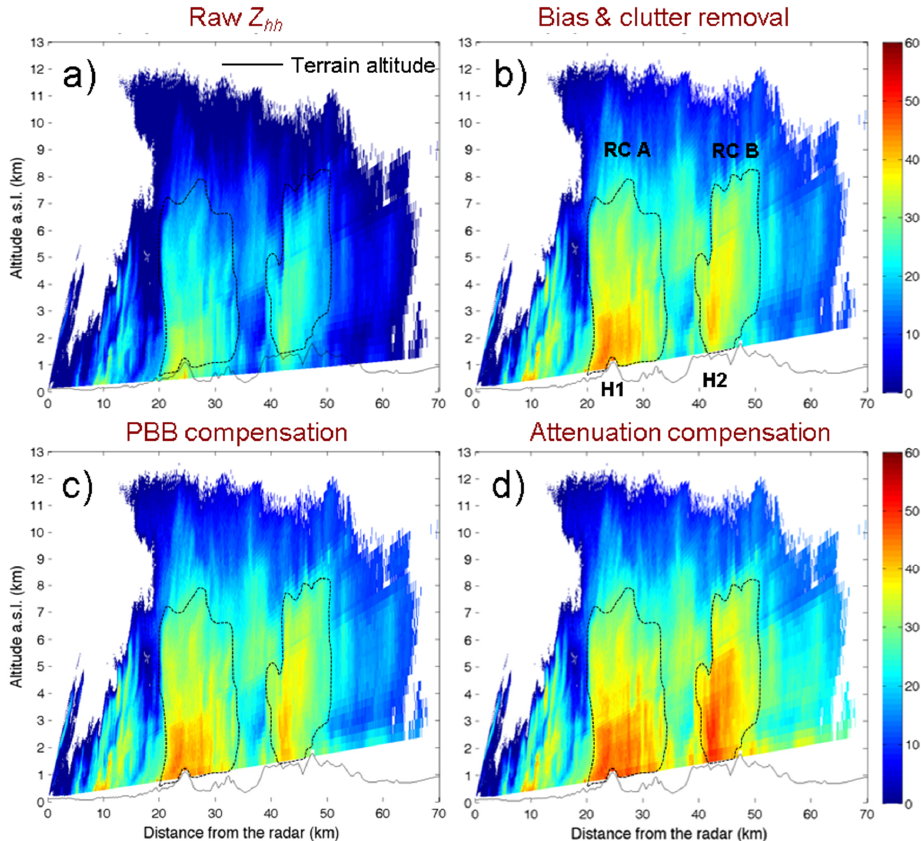
Figure A2. Example of the outcome of the radar processing chain in terms of specifically arranged Range Height Indicator (RHI), acquired by P55C radar on 14 October 2015, 13:17 UTC at 66 deg azimuth ( a ); after performing the Z hh (dB) bias compensation and clutter suppression ( b ); partial beam blocking compensation ( c ); and single polarization path attenuation compensation ( d ).